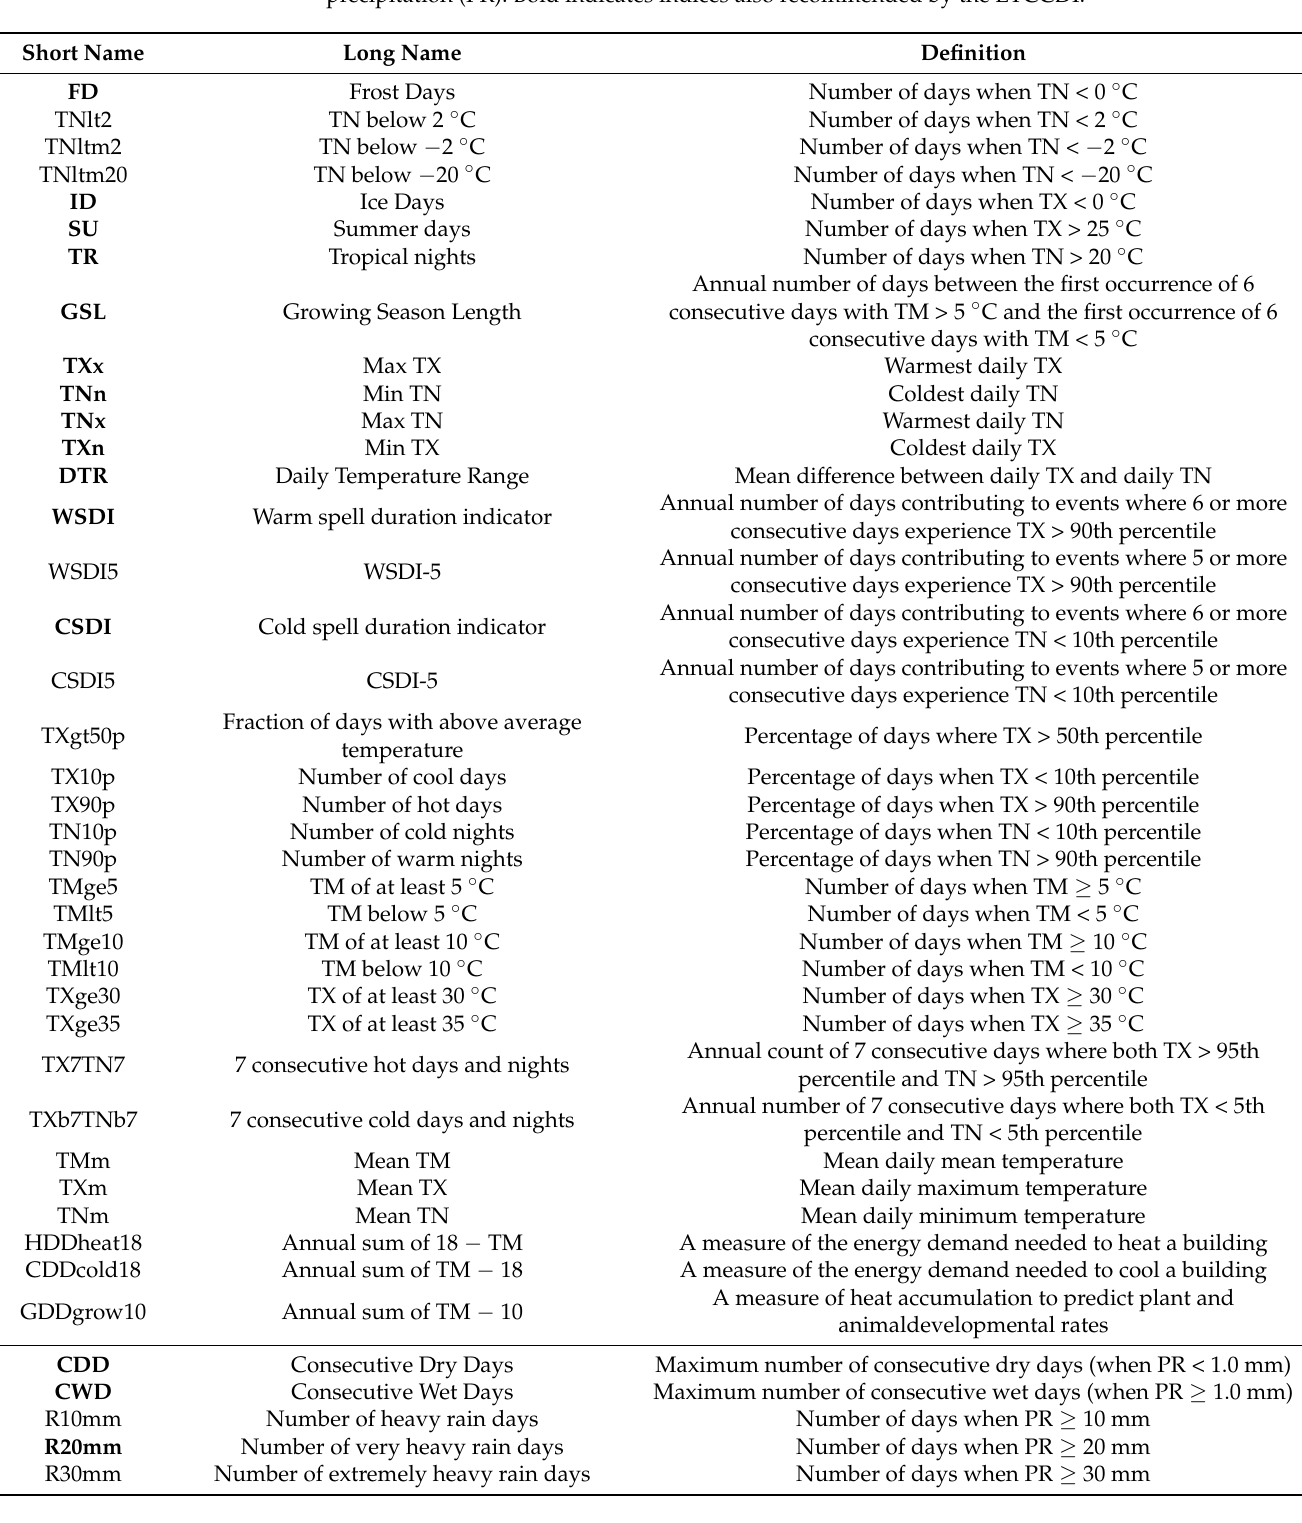
Table 3. Short name, long name, and definition of the 50 yearly CCI analyzed in the present study. The first 36 are temperature-related and last 14 are precipitation-related. The indices are defined in terms of maximum temperature (TX), minimum temperature (TN), mean temperature (TM), and precipitation (PR). Bold indicates indices also recommended by the